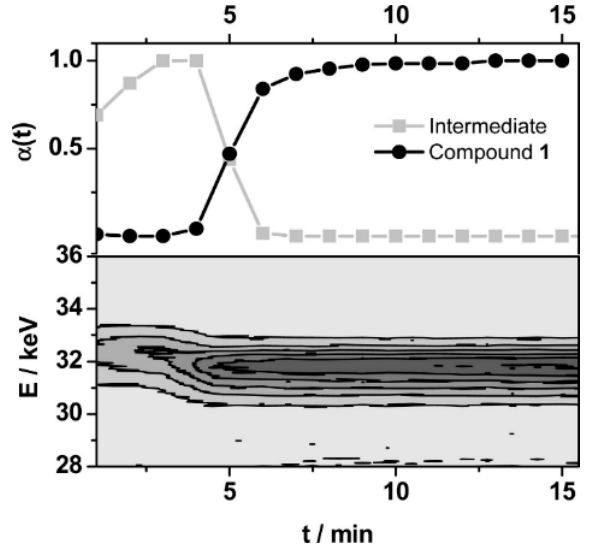
Figure 18. Surface energy-dispersive x-ray diffraction (EDXRD) plot of the transformation of the intermediate phase into Ln(O 3 P-C 4 H 8 -SO 3 )(H 2 O) (bottom) and reaction progress ( α ( t )) for both phases under conventional heating at 150 °C (top). Reprinted with permission from reference. [95]. Copyright 2010, American Chemical Society.